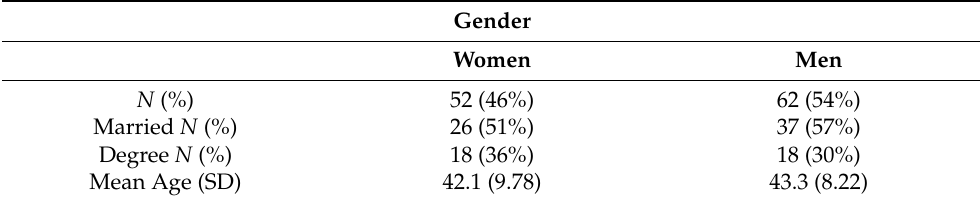
Table 1. Sample description and gender